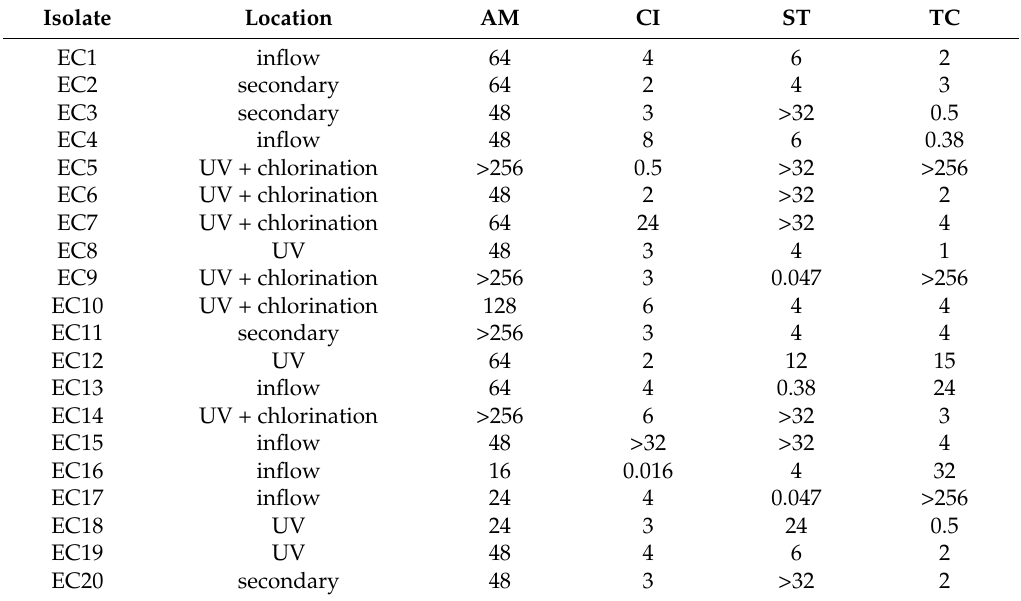
Table 5. The minimum inhibitory concentration (MIC) values of multidrug-resistant E.